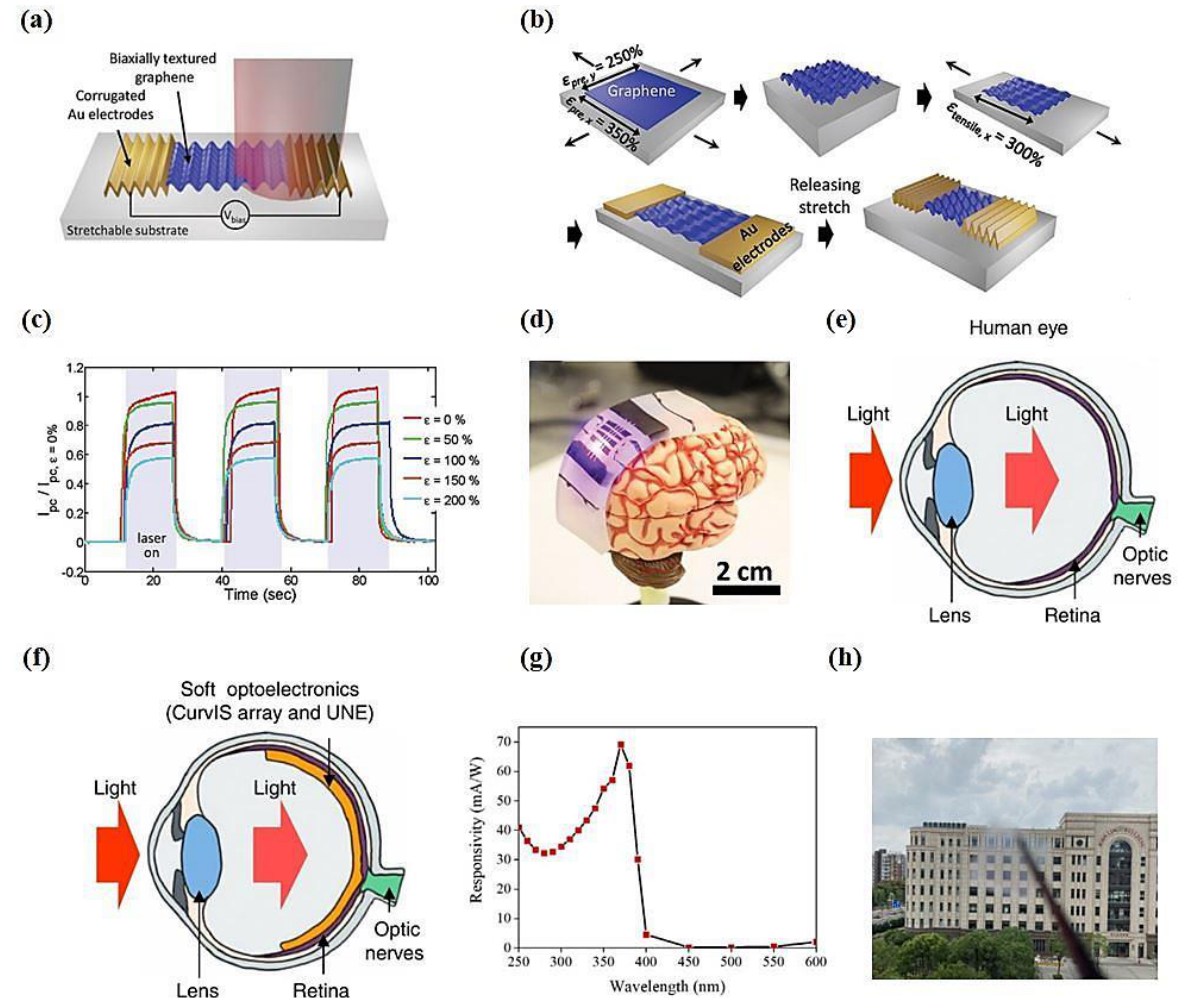
Figure 6. ( a ) Schematic diagram of a retractable PD and experimental device. ( b ) The manufacturing process of the stretchable graphene PD. ( c ) Dynamic photoresponse of the device at uniaxial tensile strains ( ε tensile,x ) varying from 0% to 200%. Measured photocurrent normalized to the photocurrent at ε tensile,x = 0%. ( d ) Highly stretchable and conformal PD on the surface of a human brain model. Reproduced with permission [157]. Copyright © 2022 WILEY − VCH Verlag GmbH & Co. KGaA, Weinheim. ( e ) Schematic illustration showing the ocular structure of humans: the human eye consists of a lens that collects light, a retina that converts light into action potentials, and optic nerves that transmit action potentials to the brain. ( f ) Schematic illustration showing the ocular structure of the soft optoelectronic device of an ultrathin soft optoelectronic device consisting of a CurvIS array and a UNE conformally laminated on the hemispherical retina. Reproduced with permission [159]. Copyright © 2022, The Author(s). ( g ) The responsivity of the spray − coated ZnO nanoparticles under a 5 V bias. ( h ) Photo of the covering glass slide after Sr 2 Nb 3 O 10 nanosheet spraying, showing the transparency of the material. Reproduced with permission [161]. Copyright © 2022 Wiley − VCH GmbH.